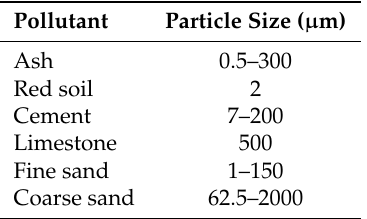
Figure 3. Pollutants used for the experiments. From left to right and from top to bottom: ash, red soil, cement, limestone, fine sand and coarse sand. Table 1. Particle size for each pollutant.